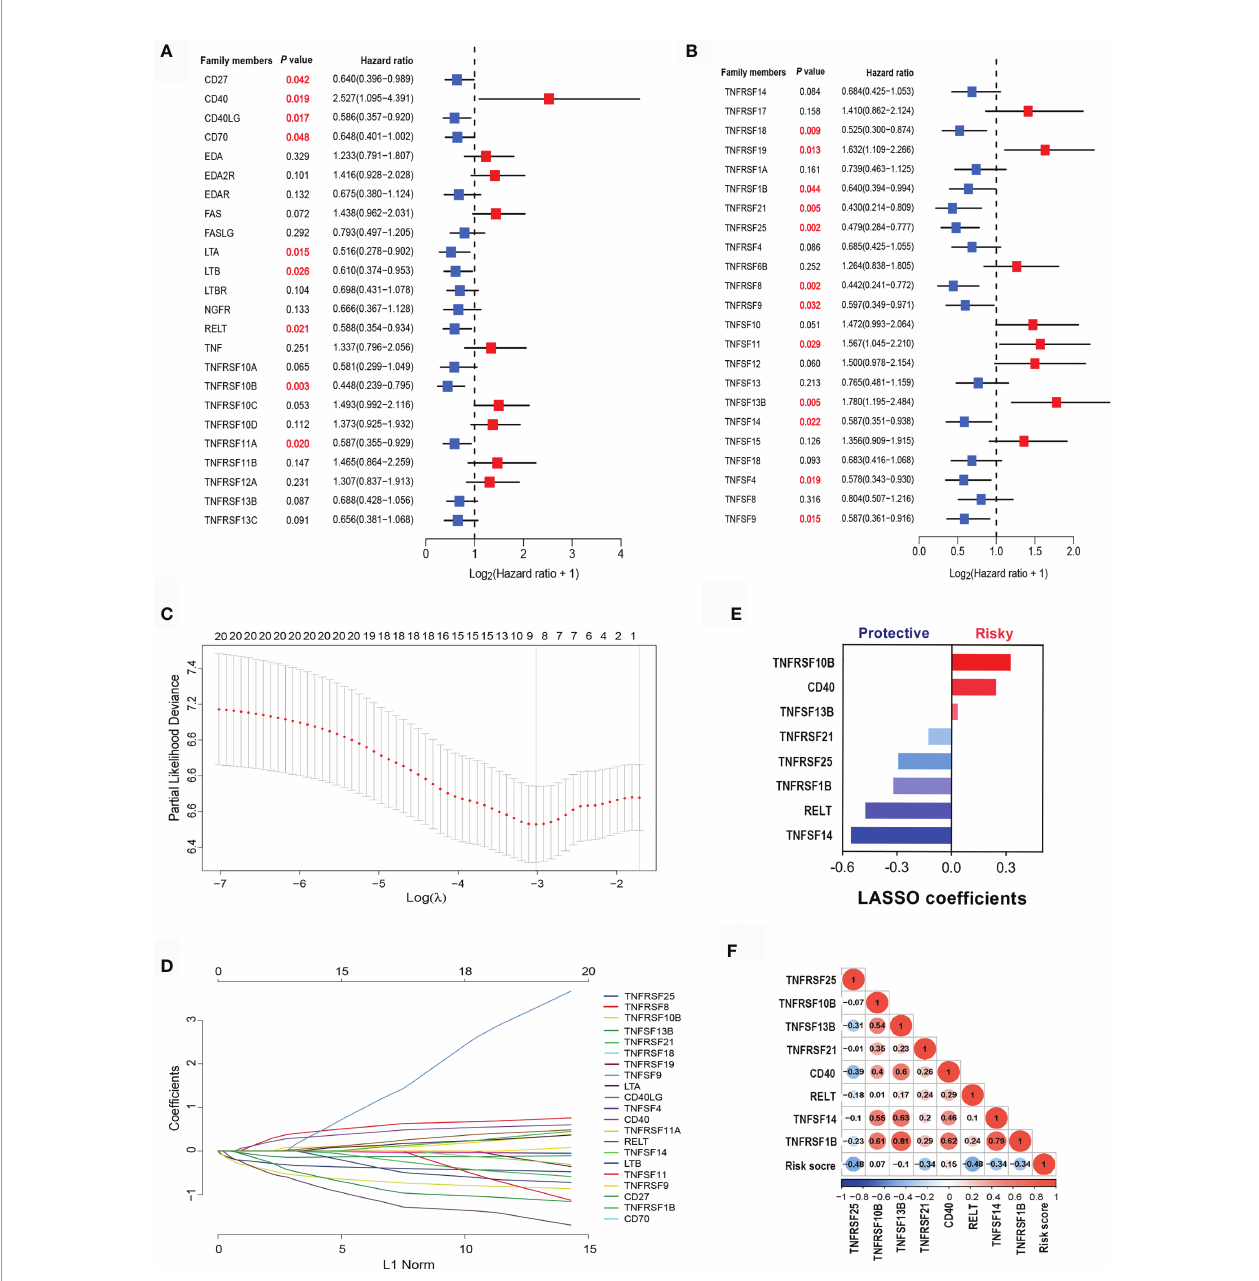
FIGURE 2 | The clinical signi fi cance of TNF family members in SCLC patients. (A, B) The forest plots of hazard ratios (HRs) show the prognostic values of TNF members. (C) Tuning parameter ( l ) selection cross-validation (n = 100) error curve for relevant prognostic genes. Red dots represent the partial likelihood deviance values, and grey lines represent the standard error (SE). The vertical lines are the optimal values according to the minimum and the 1-SE criteria. (D) The LASSO coef fi cient pro fi les of the most useful prognostic genes from the TNF family. (E) The weighting coef fi cient values for each prognostic gene. (F) Correlation matrix of the risk score and eight selected